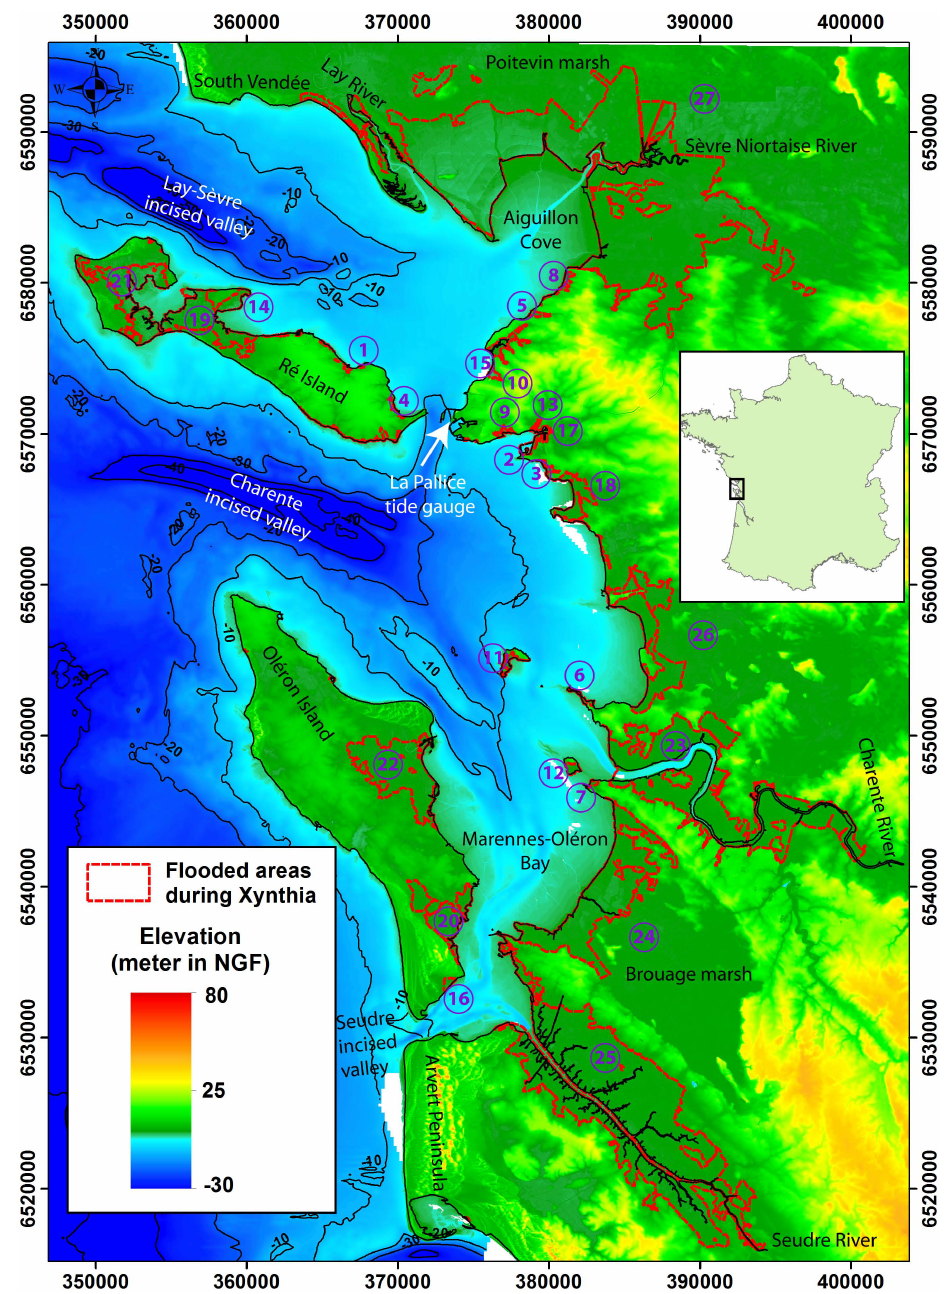
Fig. 1. LiDAR derived Digital Terrain Model (DTM) of the study area. Elevation is shown in meter NGF and the horizontal projection is in meters of Lambert 93 projected coordinate system. Circled numbers 1 to 27 are the studied marshes. The red dotted line shows the extension of the observed flooded areas caused by the Xynthia